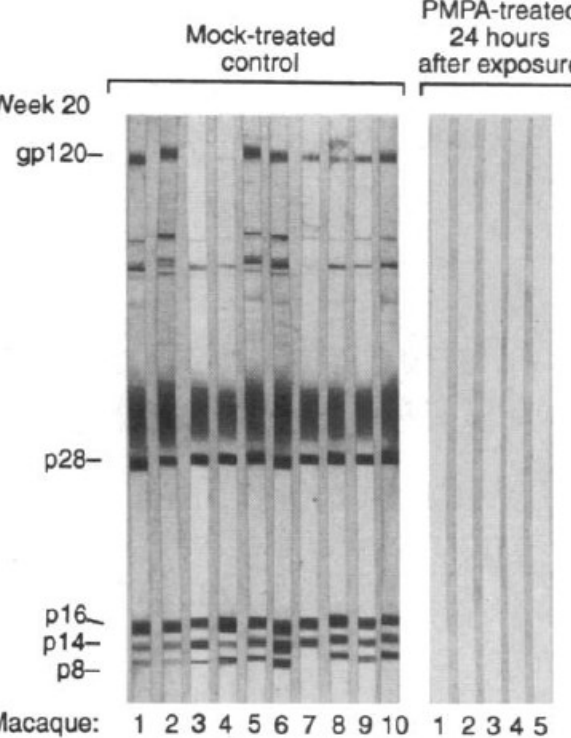
Figure 3. Activity of ( R )-PMPA when injected shortly before or after SIV infection in rhesus macaques: first prediction that tenofovir may be effective in therapy and prophylaxis of HIV infection in humans (figure taken from Tsai et al. [34]).